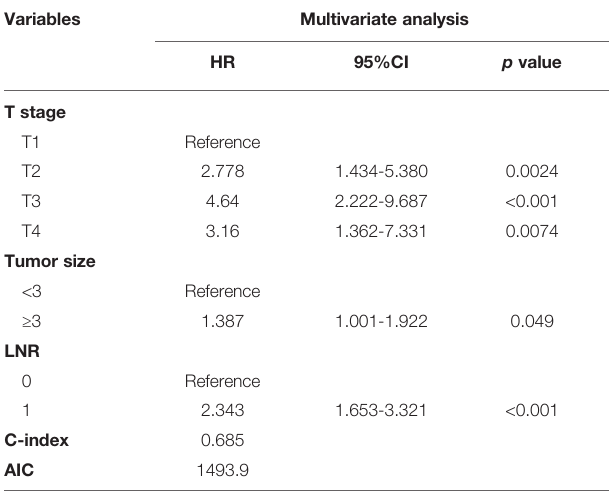
(c) Multivariate Cox analysis of prognostic factors including